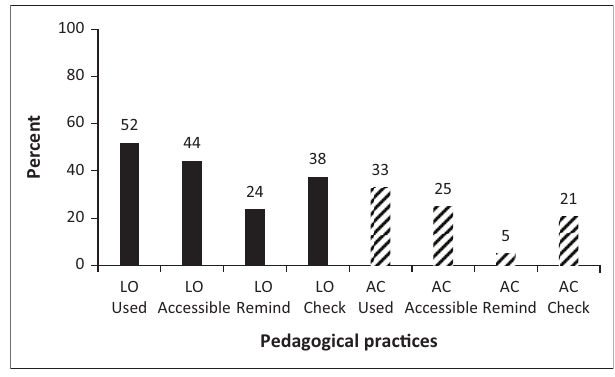
FIGURE 3: Percentage of teachers who met all the key criteria in the application of formative assessment strategy